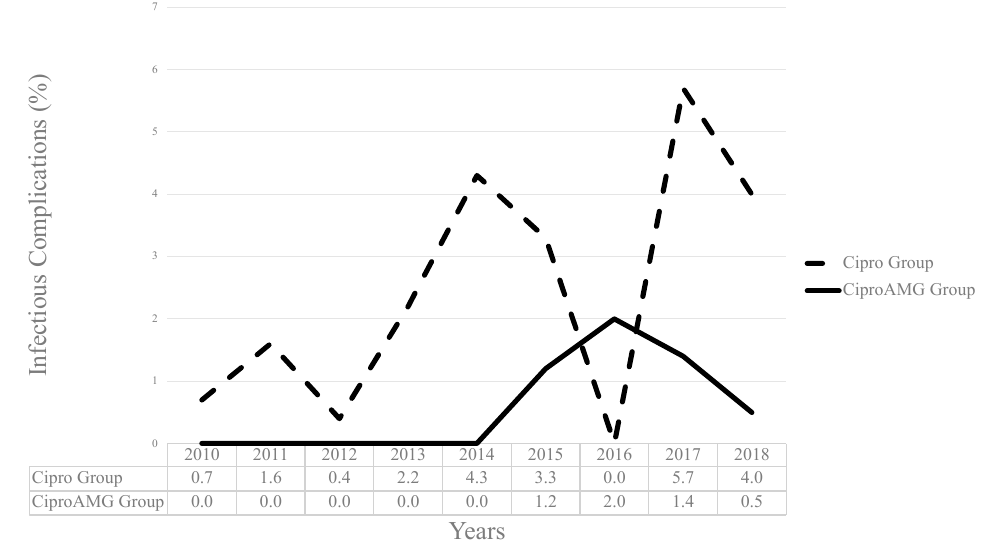
Figure 2. Pooled post-prostate biopsy infectious complications rates from 2010 to 2018. The rates per year are shown in a linear trend and are stratified according to groups (Cipro group and CiproAMG group).